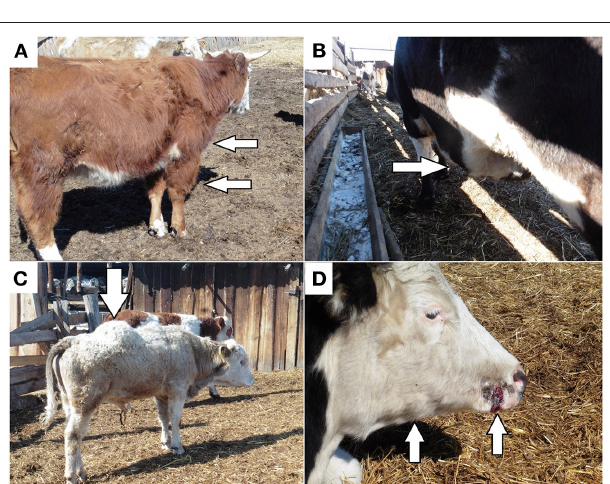
DISCUSSION Blackleg is considered an infection that occurs when the animals are on pasture due to the abundance of dry grass, with summer- autumn seasonality. Rarely, the disease occurs in winter and spring and is caused by non-compliance with sanitary standards and the failure to administer preventive vaccinations (7, 17,